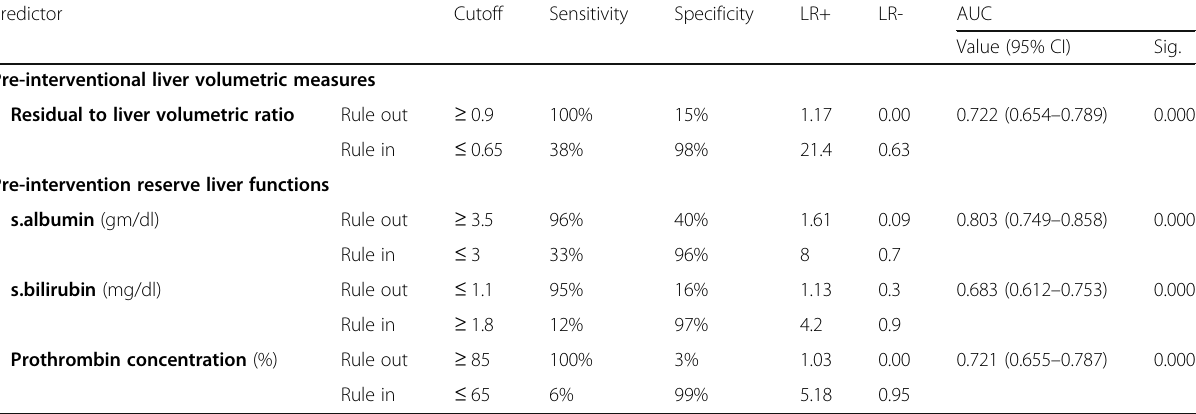
Table 4 Receiver operating characteristics of the significant predictors Predictor